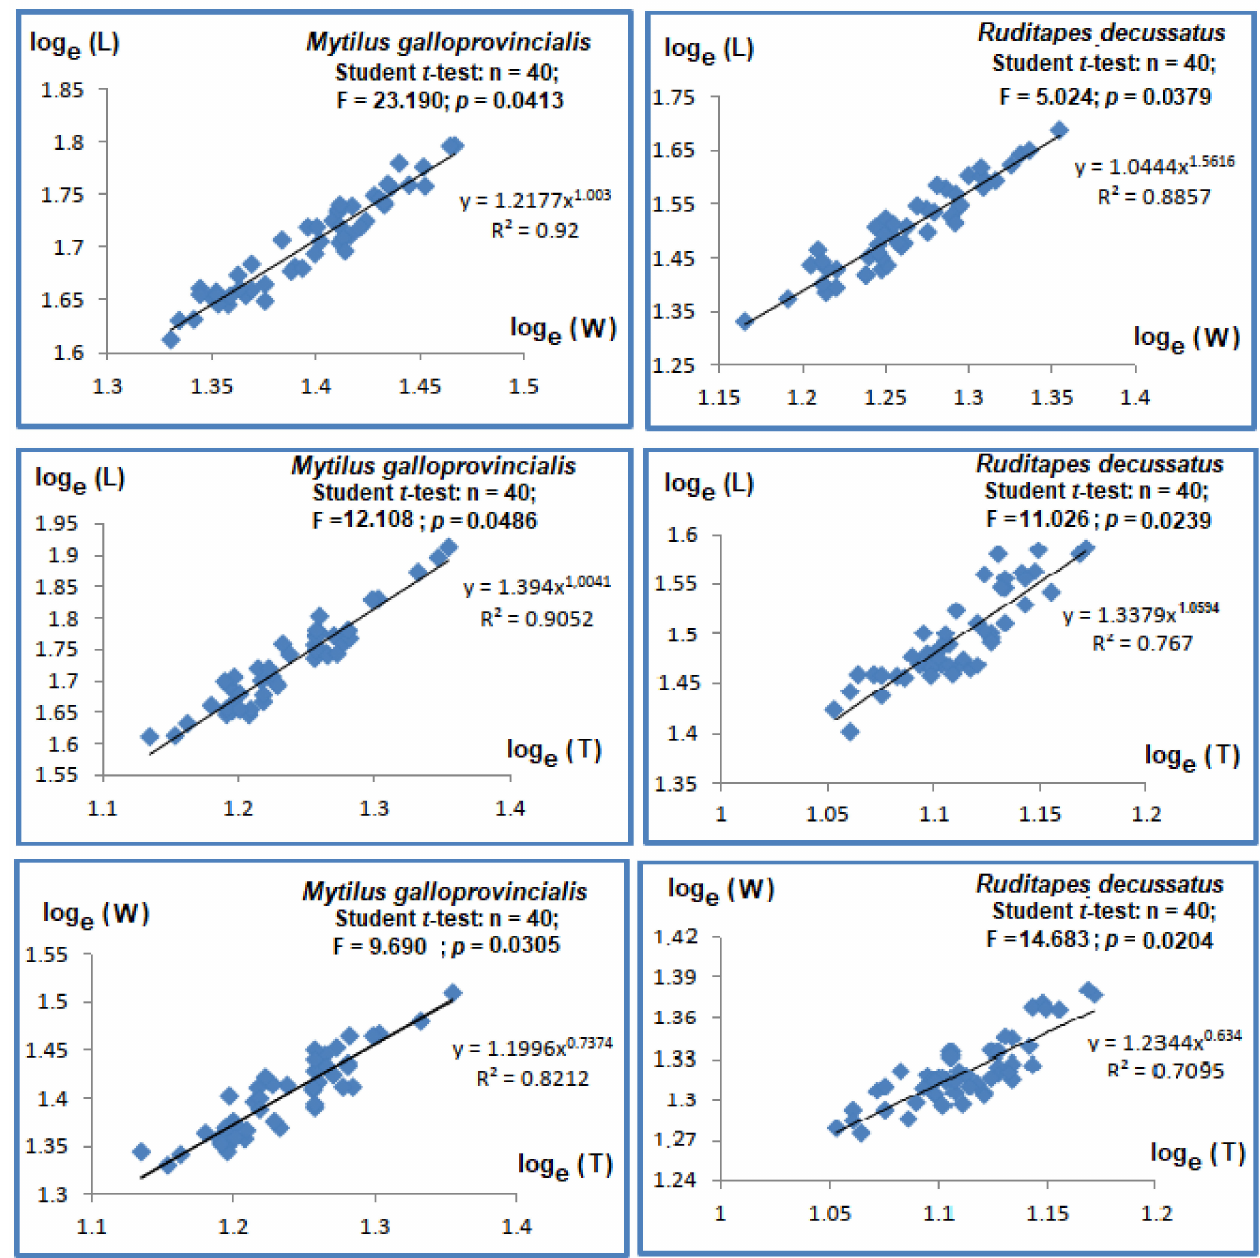
Figure 2. Regressions relating linear parameters in bivalve species Mytilus galloprovincialis and Ruditapes decussatus . Length (L); Width (W); Thickness (T). The relative mass growth rates were assessed through regressions between Total Fresh Mass (TFM), Fresh Chair Mass (FCM), Fresh Shell Mass (FSM), and length (L) (see Figure 3). The regressions among various types of masses to length were inter-correlated ( p -values < 0.001, R 2 > 0.7). The comparisons of slopes with Student t -tests to the theorical value of 3 supported significant differences between masses and length. The allometry was minor, given all slopes had values below